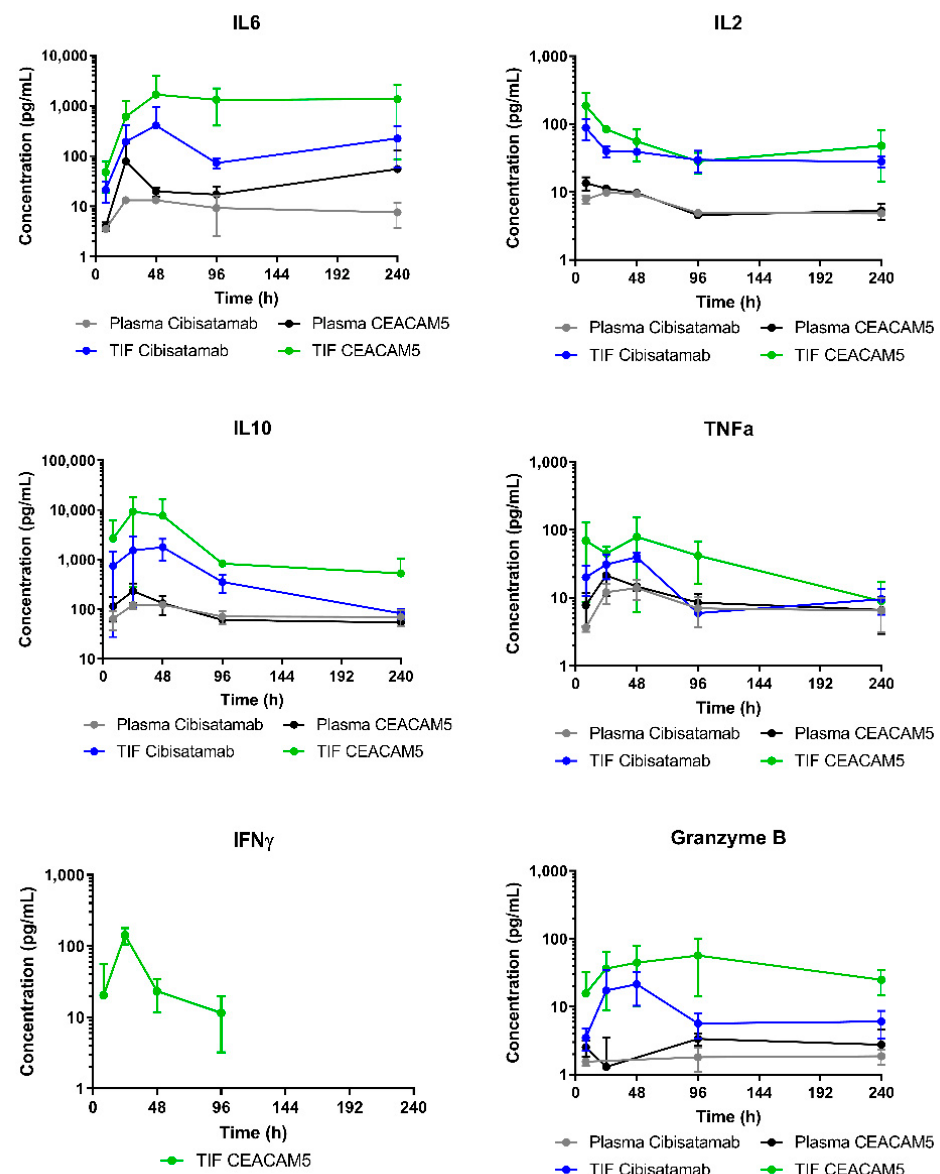
Figure 6. Cytokine profiles in plasma and TIF after single dose TCB i.v. injection: Cytokine (IL2, IL6, IL10, TNF α , IFN γ and Granzyme B) concentration profiles during the first 10 days after 2.5 mg/kg TCB injection, captured in plasma and in isolated TIF for cibisatamab ( n = 18, grey and blue re- spectively) and CEACAM5-TCB ( n = 17, black and green respectively). Data are represented as mean ± SD. IL2 and Granzyme B showed significantly higher levels in TIF vs. plasma ( p < 0.009 and <0.03, respectively). Despite a consistent trend across all cytokines, the other cytokines showed no statistically significant differences, neither in TIF vs. plasma nor between the two TCB